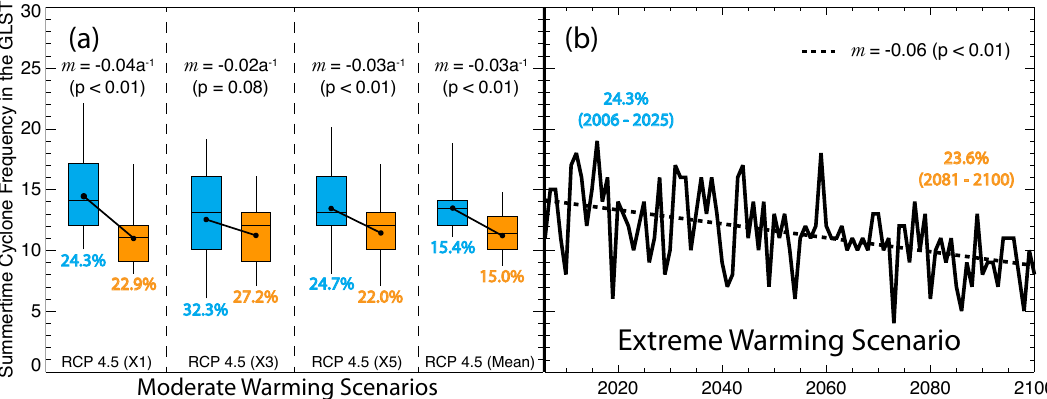
Fig. 7. Change in summer GLST cyclone frequency over the 21st century. (a) Box and whisker plots of the cyclone frequency in the base period (blue; 2006–2025) and future period (orange; 2081–2100). Solid line connects the mean of the base and future period. The slope of the least-squares regression and significance of the slope are shown for each simulation. The variability in the base and future periods are listed below the box and whisker in blue and orange, respectively. (b) Time-series evolution of the summertime GLST cyclone frequency in the RCP 8.5 extreme warming scenario. The significant ( p < 0 . 01) least-squares regression is shown as a dashed line with a slope of − 0 . 06a − 1 . The variability for the future and base period are listed in blue and orange